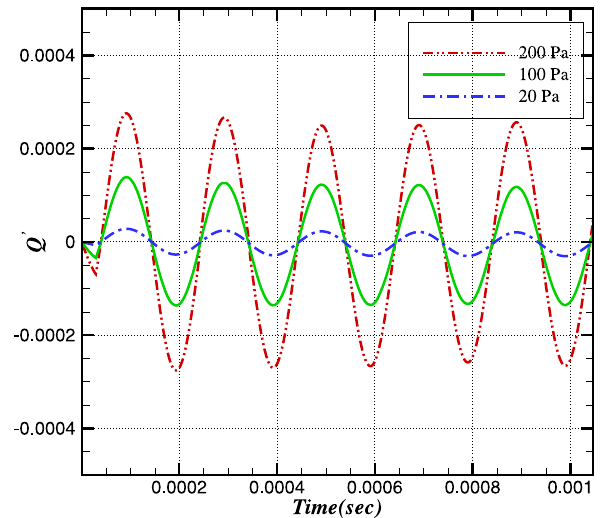
Figure 12. Relative change in the reaction rate of OH at different amplitudes and a constant frequency of 5 kHz.